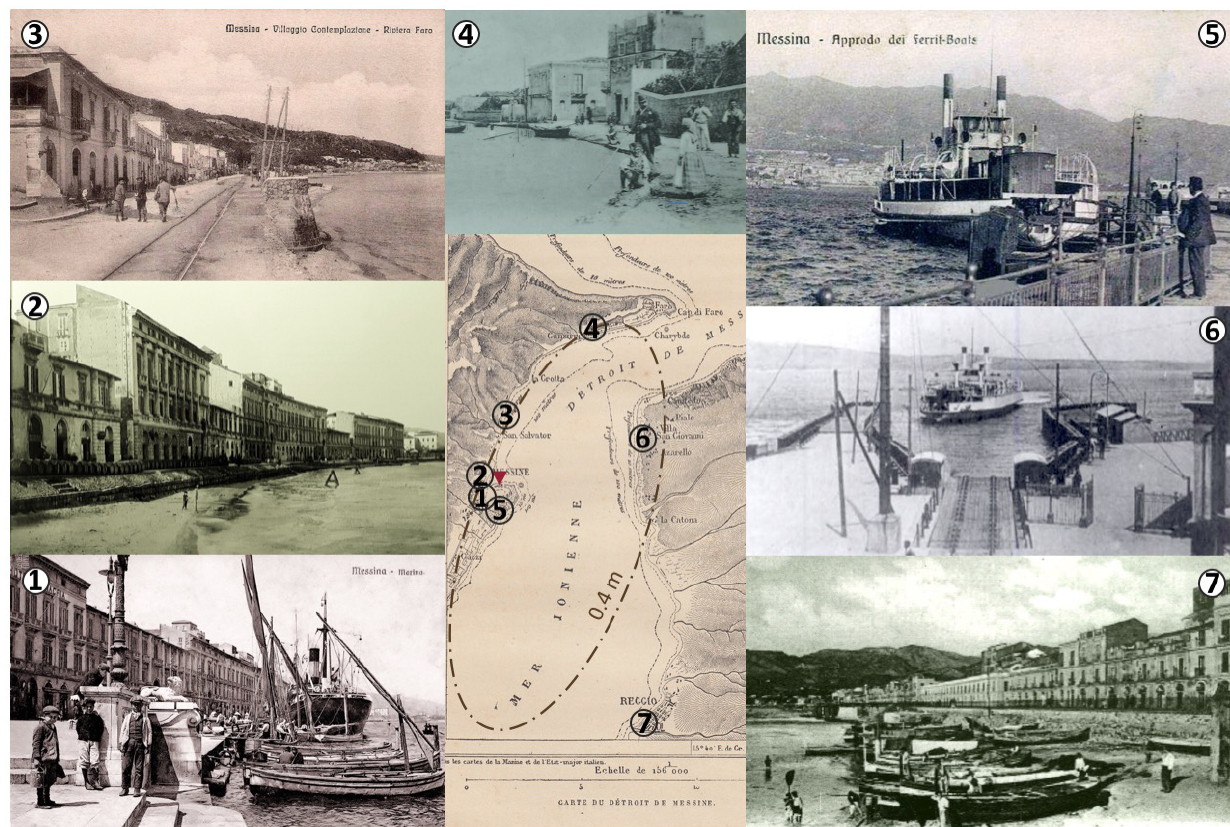
Figure 3. Images of the shoreline at several locations (relevant numbers on the map) in Messina and Reggio Calabria. All the photographs date back to a few years preceding the 1908 earthquake. The dashed ellipse marks approximately the 0.4m subsidence isoline according to Barreca et al. (2021). If such a macroscopic vertical change ever occurred, it would have had significant consequences on people’s daily lives along the Messina Straits